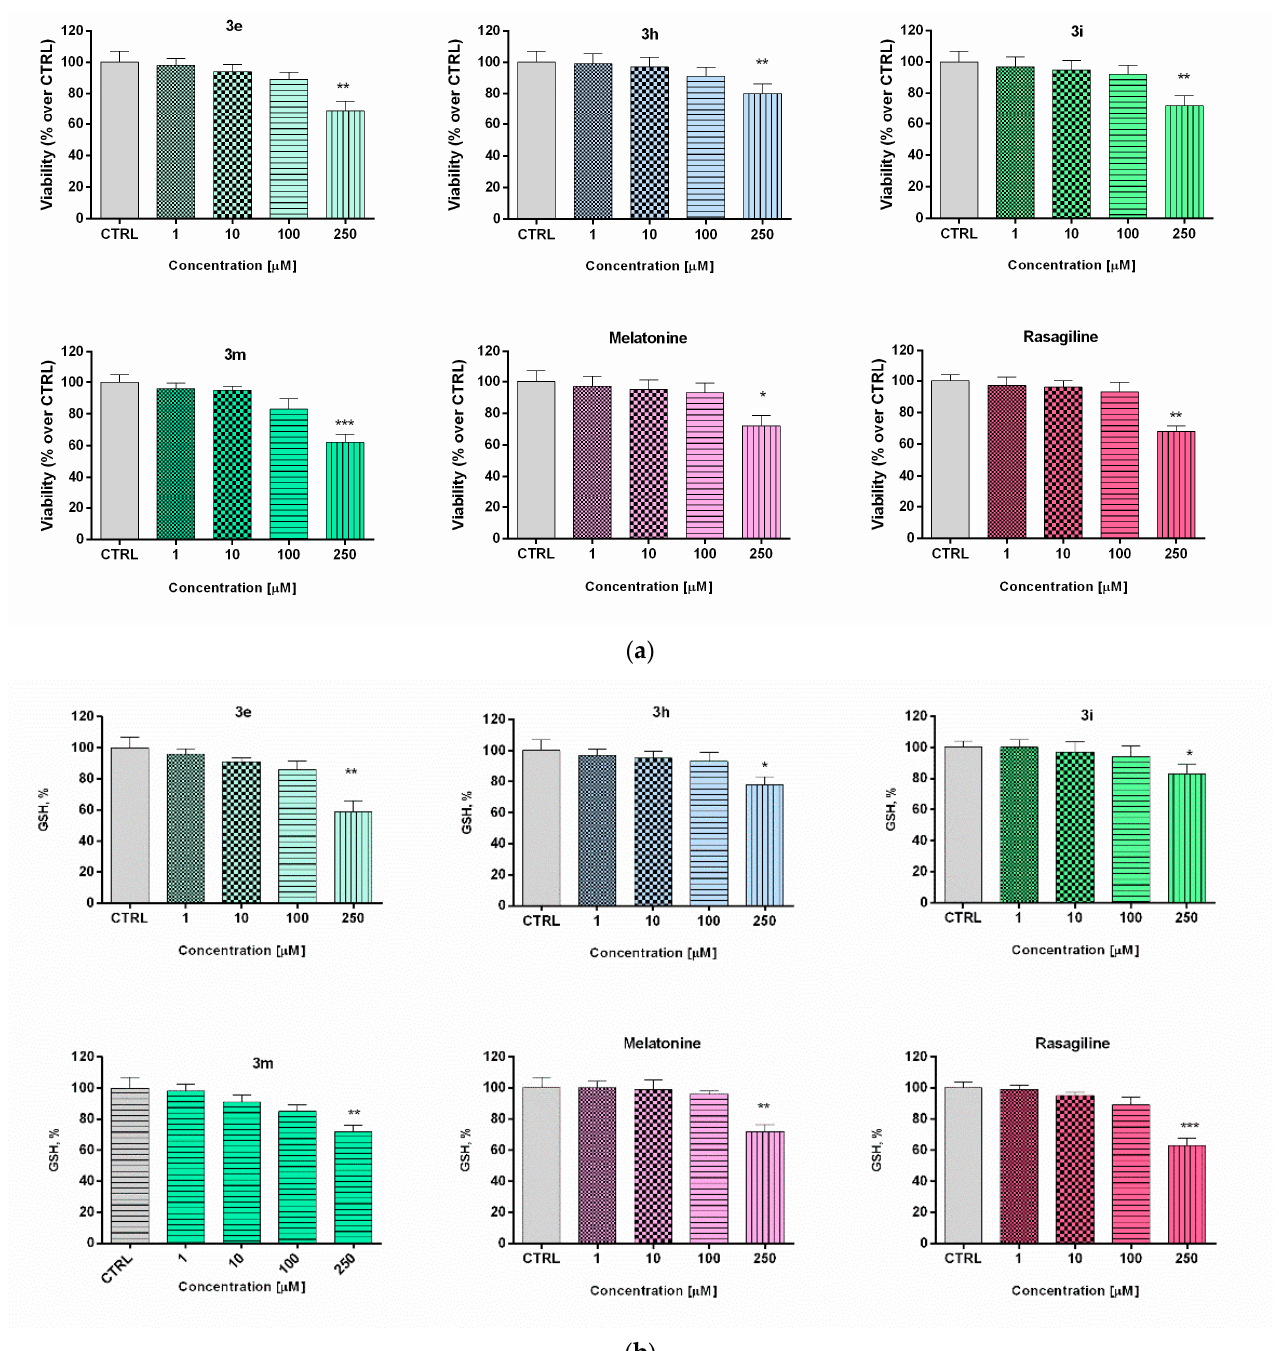
Figure 2. Effect of the new arylhydrazone derivatives on: ( a ) synaptosomal viability and ( b ) GSH levels. Synaptosomal viability was assessed after treatment with various concentrations of the new benzimidazole arylhydrazones 3e , 3h , 3i , and 3m at concentrations 1, 10, 100, and 200 μ M, and after treatment with the reference compounds melatonin and rasagiline at the same concentrations. Data are presented as means from three independent experiments ± SD. * p < 0.05, ** p < 0.01, *** p < 0.001, vs. control (one-way analysis of variance with Dunnet’s post hoc test).